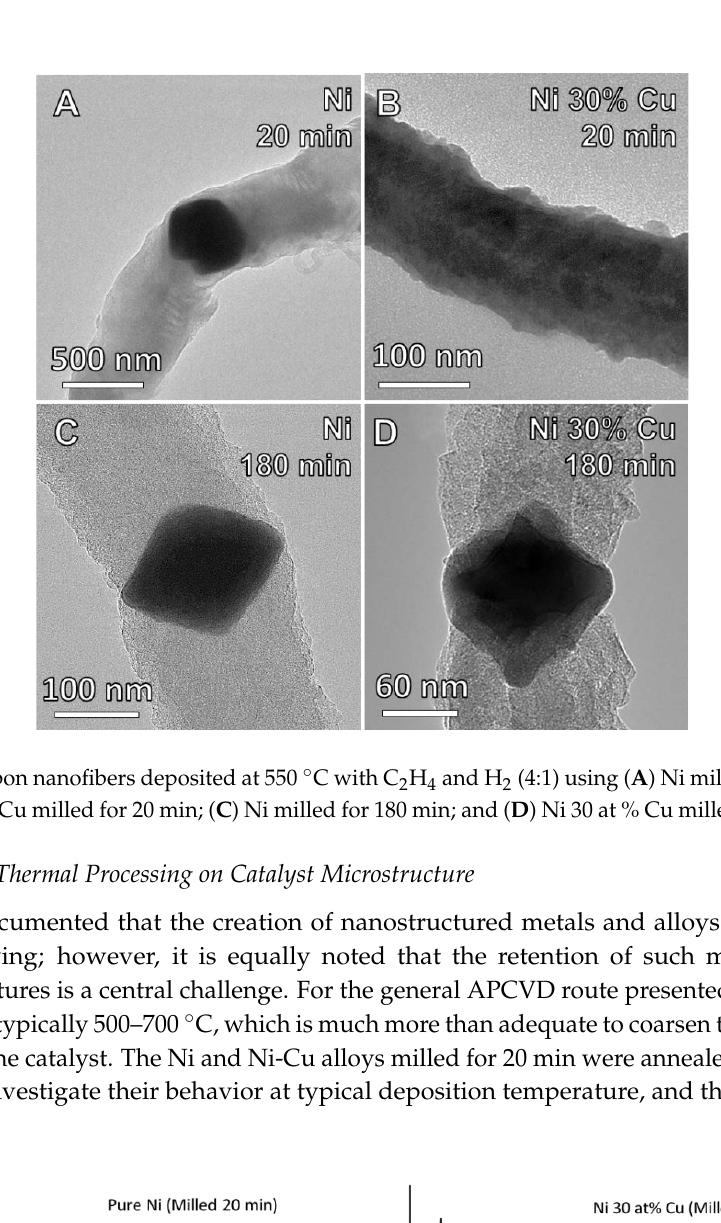
Figure 7. XRD patterns collected from ( A ) Ni and ( B ) Ni 30 at % Cu after milling for 20 min and annealing at the listed temperatures for 1 h in 5% H 2 (bal. Ar).